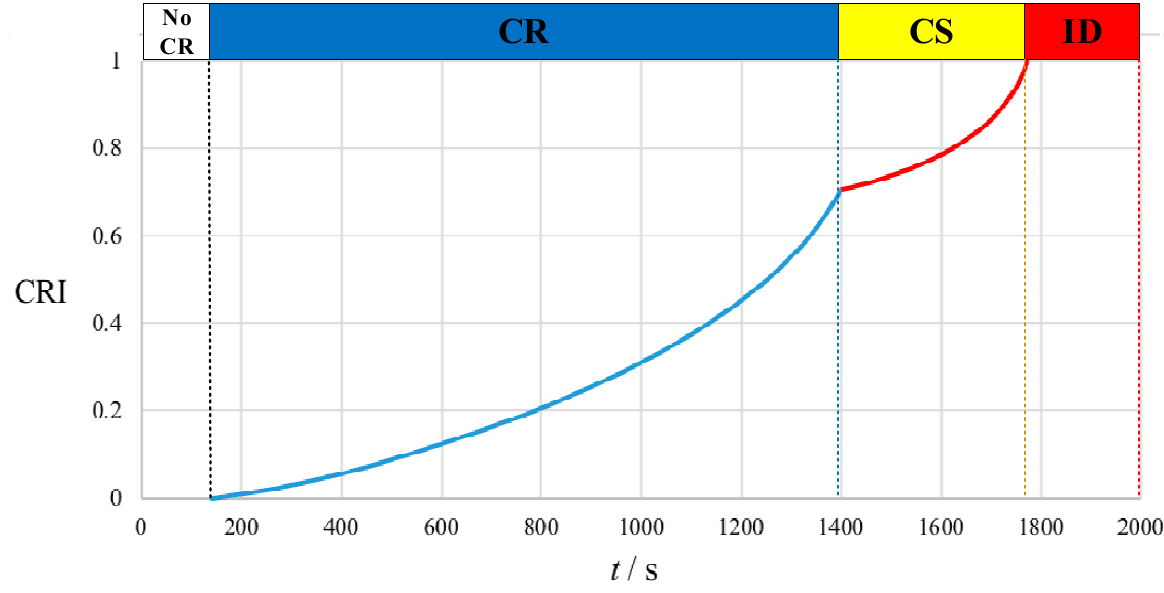
Figure 14. Minimum course-alteration angle for the stand-on vessel in an overtaking situation. The blue and red curves represent the minimum course-altering amplitude required to ensure that ship domain and collision domain are not invaded at different moments by the stand-on vessel in the risk of collision and close-quarter situation stages. According to Figure 14, the CRI is shown in Figure 15.